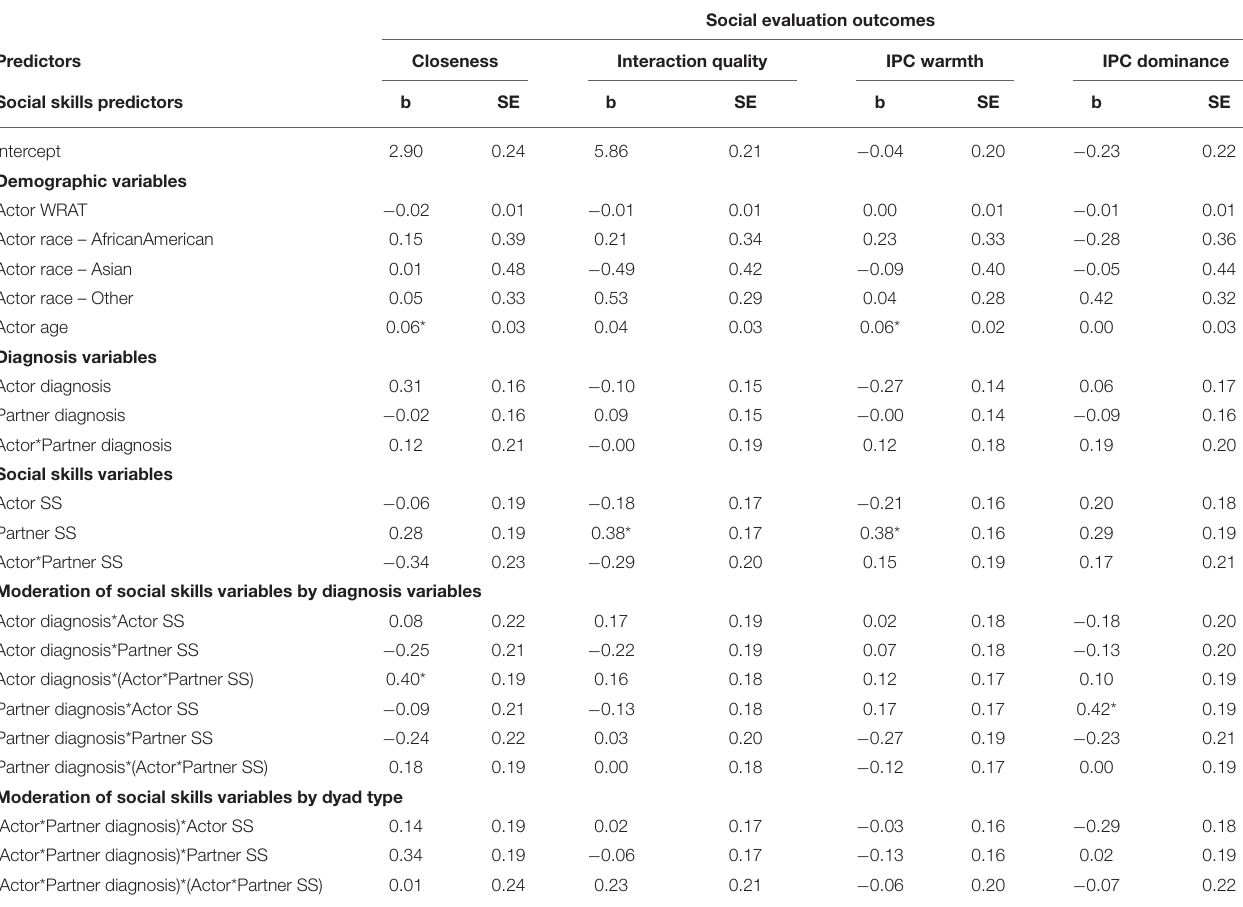
TABLE 8 | Actor-partner interdependence model analyses estimating the combinatorial effects of diagnostic status and social skills variables on the social evaluation outcomes of closeness, interaction quality, warmth, and